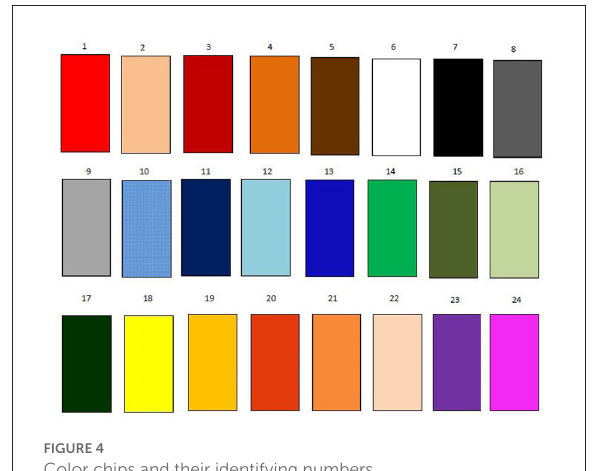
FIGURE4 Color chips and their identifying